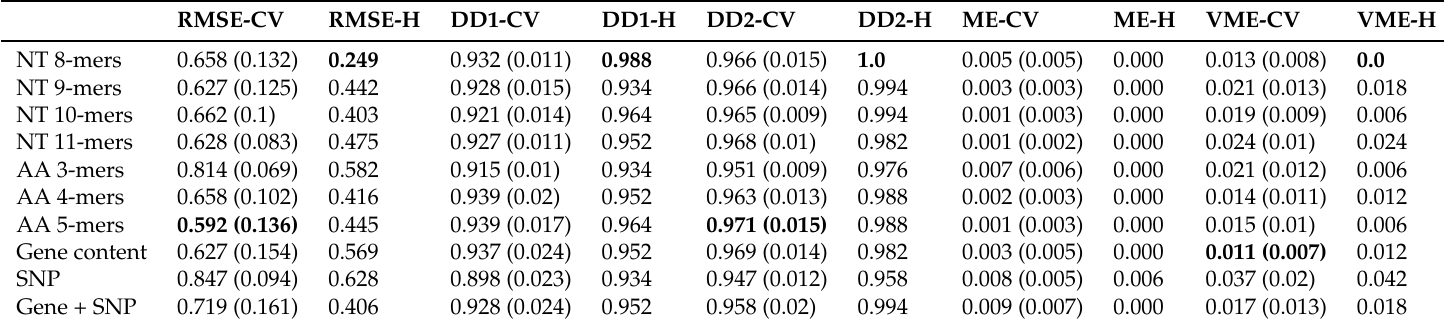
Table A45. K. pneumoniae –cefazolin.